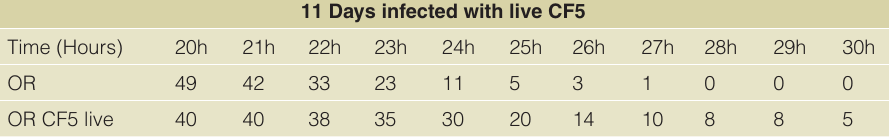
Table S2. Survival kinetics of wt PA14 infected flies 11 days post priming with live Pseudomonas aeruginosa CF5. Oregon R (OR) uninfected flies (n=49) and OR infected with live CF5 bacteria (n=40) for 11 days were injected with the virulent PA14 strain. Top row numbers indicate the time in hours post injection whereas lower rows the corresponding number of surviving flies in naive and primed flies respectively. Sample size is indicated at